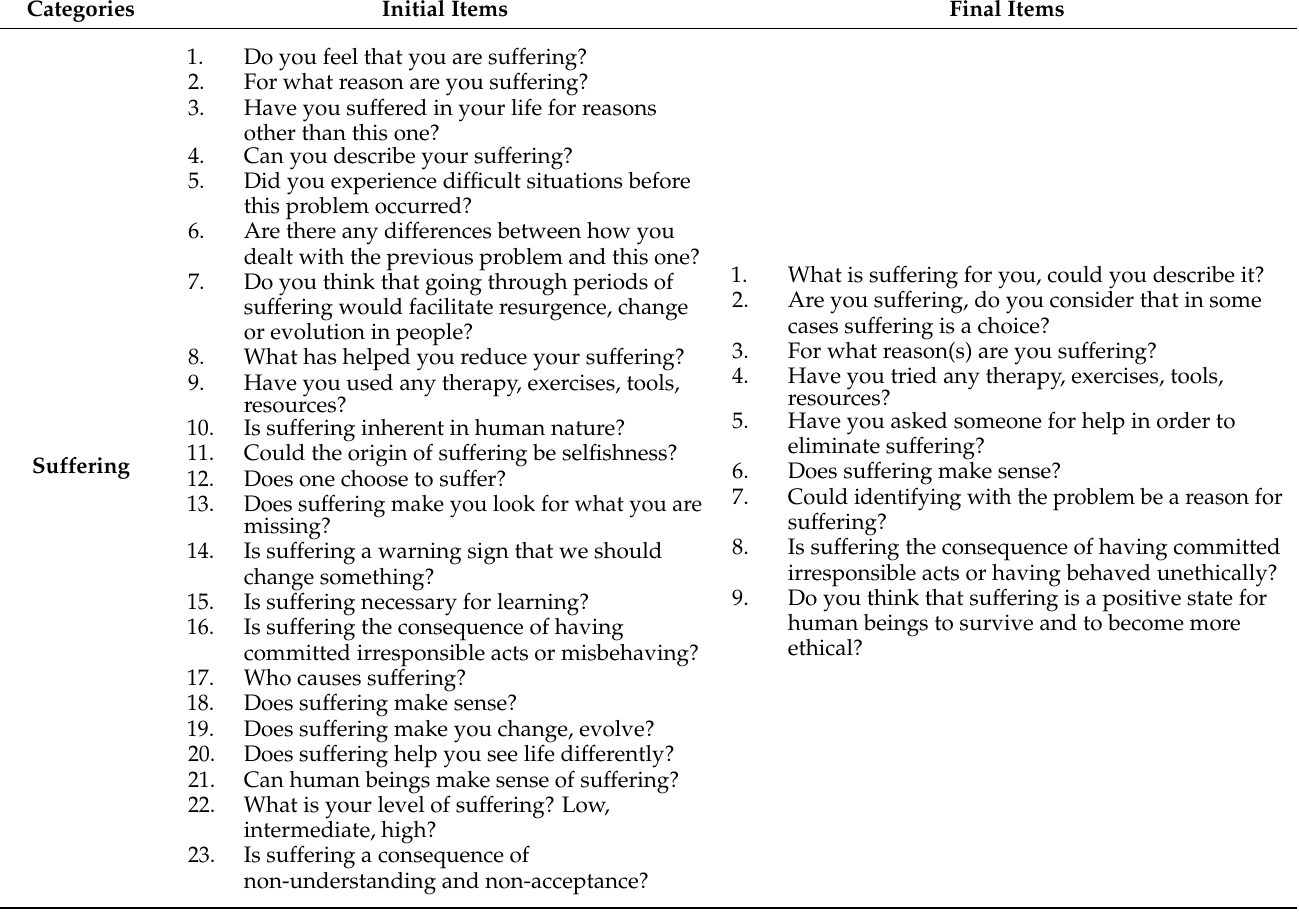
Table A1. Semi-structured interview “the management of suffering in people suffering from illness, relationships, economic problems, and adaptation to the